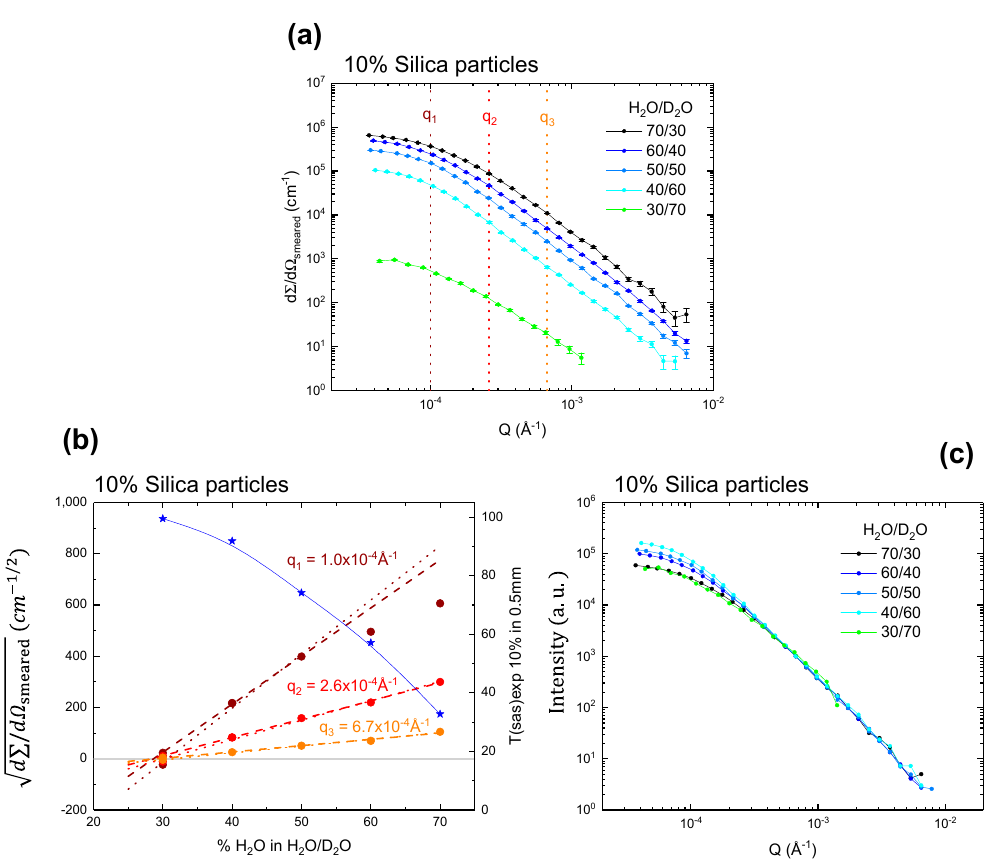
Figure 3. Contrast variation with 10 vol % SiO 2 at pH 10. ( a ) Scattering curves of samples with different H 2 O/D 2 O ratios; ( b ) left axis: the square root of the scattering intensity as a function of vol % H 2 O in H 2 O/D 2 O ratio and q value (brown, red, and orange symbols for the three distinct q-values). The fitted line corresponds to the data with a positive sign (dashed line) and negative sign (dotted line) sign for the first point, respectively. Right axis: T SAS,exp in 0.5 mm path length (blue stars) as a function of vol % H 2 O in H 2 O/D 2 O ratio; ( c ) a plot of the scattering curves from ( a ) normalized to the same value at high q .